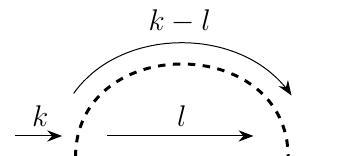
Figure 4 . The self energy diagram for the (cid:30)